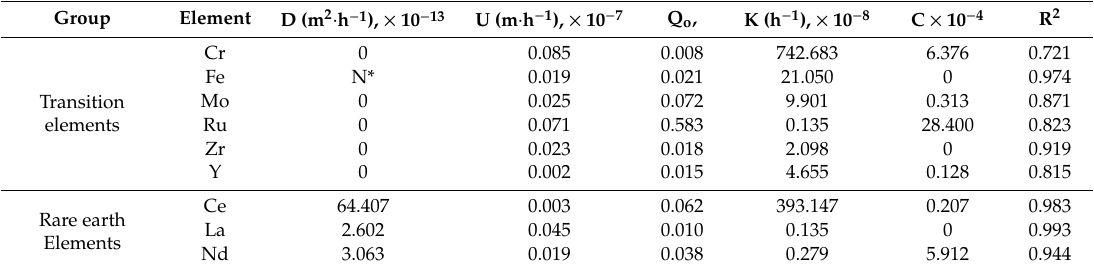
Table 17. Nonlinear curve fitting parameters of the cumulative leach fraction of transition and rare